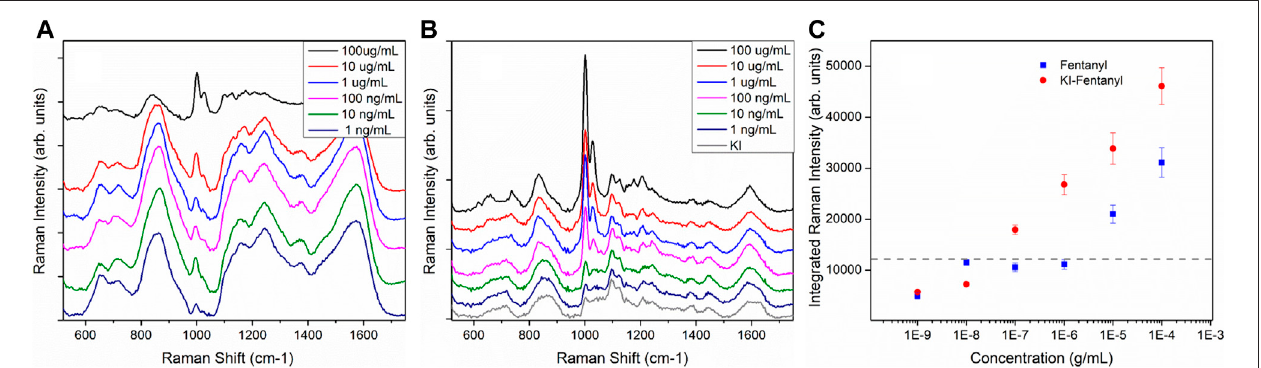
FIGURE 4 | (A) SERS spectra of inkjet-printed SERS sensors directly exposed to various concentrations of fentanyl. Spectra have been offset for clarity. (B) . The printedsensorsare fi rstmodi fi edwith1 mMKIfollowedbyexposuretothefentanyl.ThegreyspectrumshowstheSERSbackgroundobtainedfromasensorexposedto 1 mM KI overnight. Spectra have been offset for clarity. Each of the spectra shown here is an average of 10 spectra acquired from ten random spots on the sensors. All spectrashownherewereacquiredwithReporteRhandheldRamananalyzer. (C) .Integratedintensityofthe1,002and1,029 cm − 1 doubletofbothsetsofsensors. The dashed line shows averaged background intensity obtained from blank sensors. Each spectrum shown here is the average of 10 spectra taken from 10 random spots of each